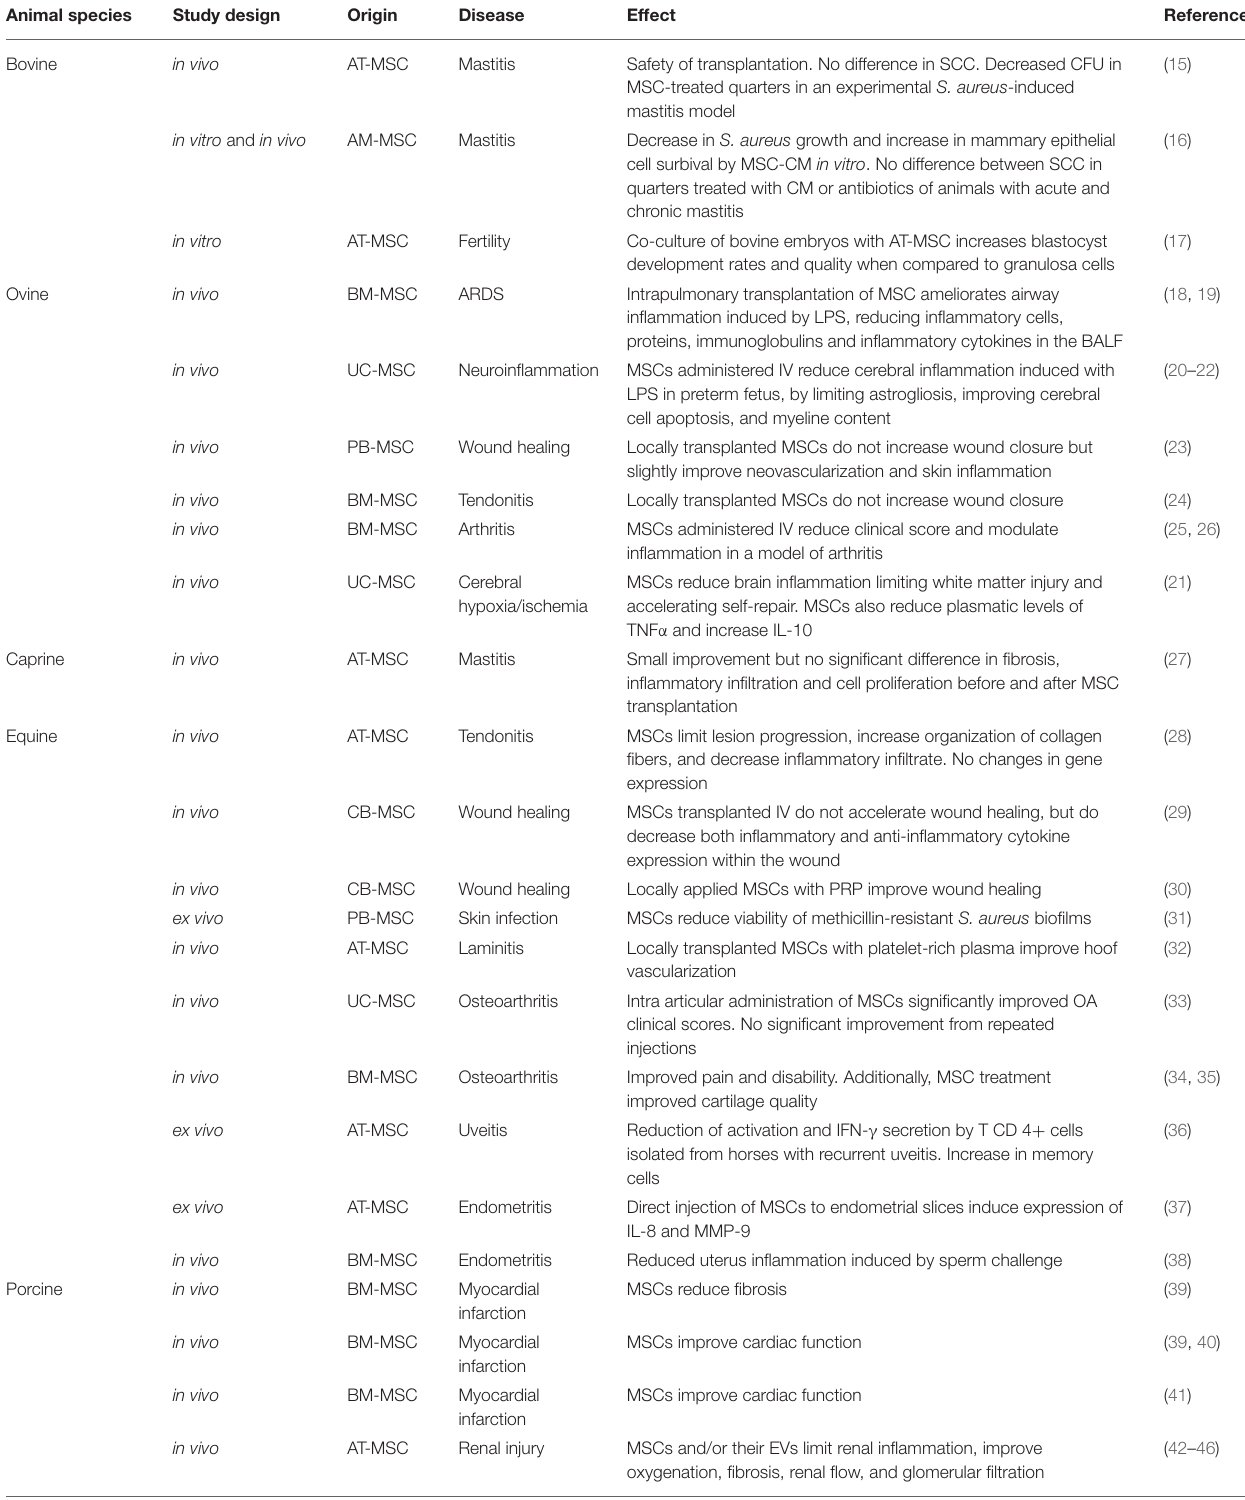
TABLE 1 | Effects of mesenchymal stromal/stem cells (MSCs) on inflammatory conditions in livestock animals. Animal